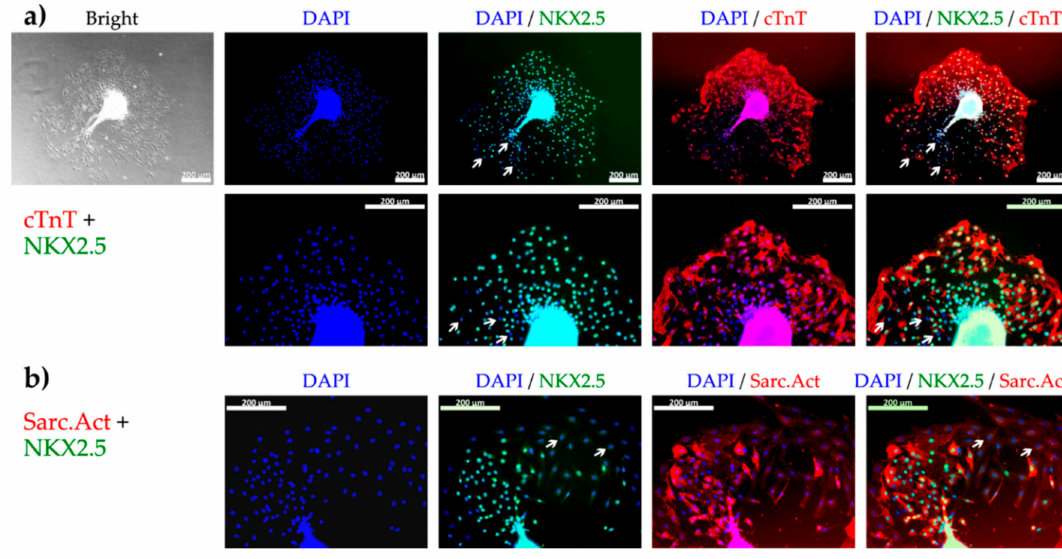
Figure 4. The presence of cardiomyocytes (CM) among cells growing out from the spheroids 48 h after plating determined by fluorescence microscopy of CM specific markers. ( a ) Bright field image of cell outgrowth from a spheroid and subsequent fluorescence microscopy showing nuclei (DAPI, blue), early CM specific transcription factor (NKX2.5, green), and cardiac troponin T (cTnT, red), at 10 × (top) and 20 × (bottom) magnification. ( b ) Fluorescence microscopy showing nuclei (blue), NKX2.5 (green), and sarcomeric actinin (Sarc.Act, red) at 20 × magnification. Most of the cells were positive for both NKX2.5 and cTnT or NKX2.5 and Sarc.Act revealing their CM phenotype. White arrows show NKX2.5 negative nuclei indicating the presence of non-cardiac cells. Scale bars represent 200 µ m. Table 1. The compounds used in these experiments and their expected effect on cell outgrowth. Compound